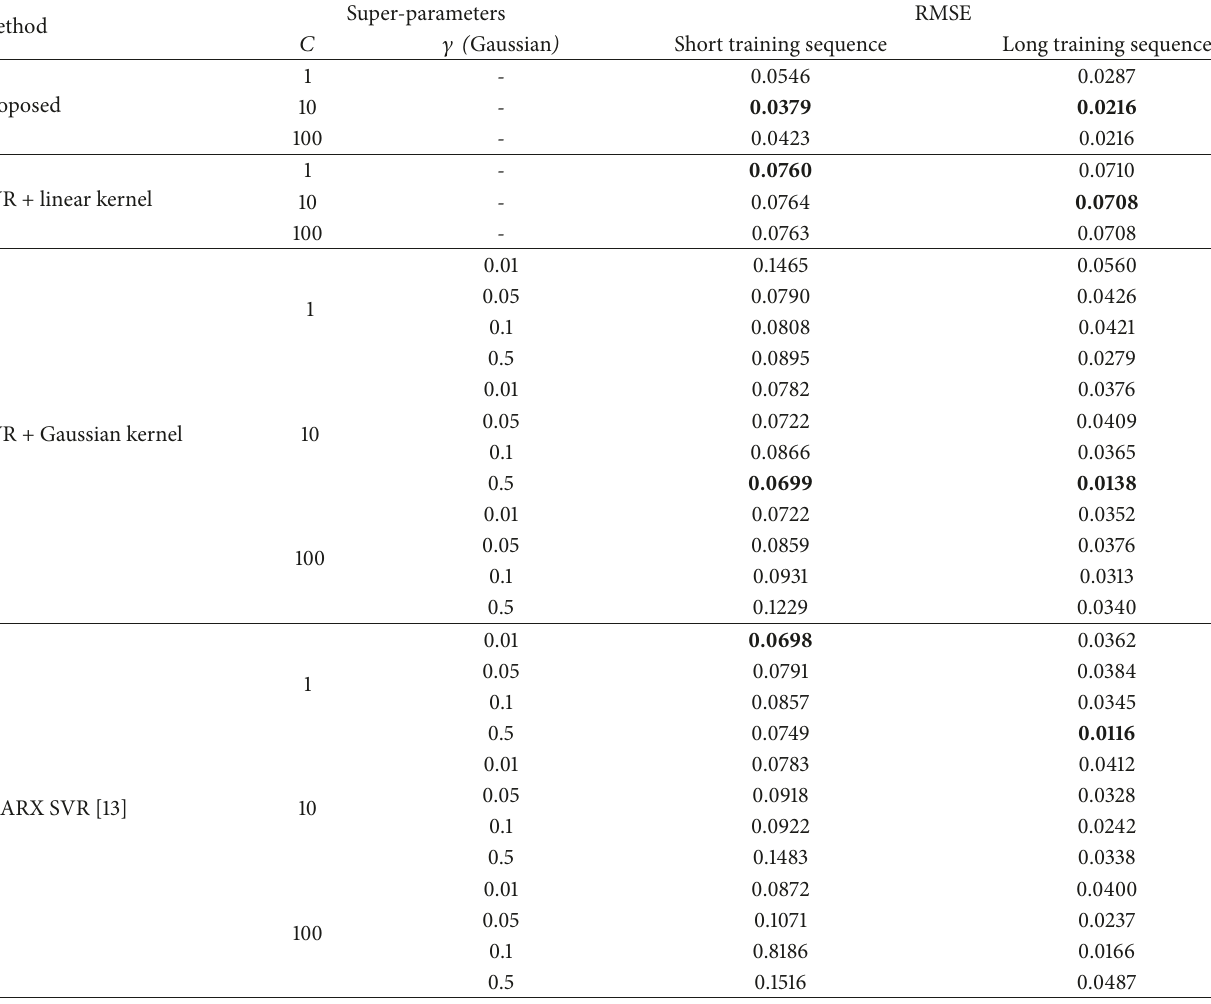
Table 2: Simulated results of the SVR-based methods for rational system.